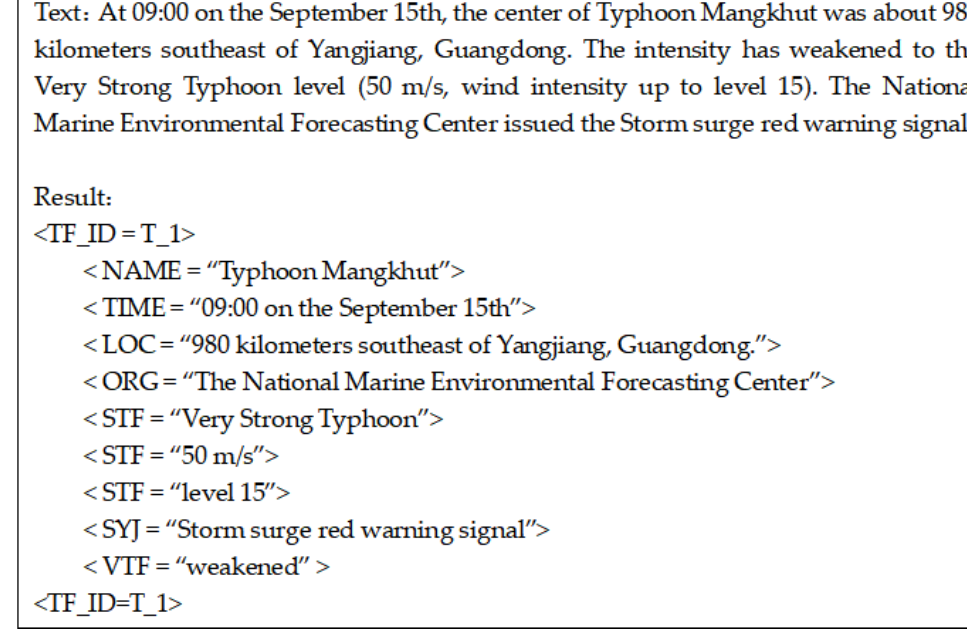
Figure 10. Part of the typhoon event graph in Neo4j database (In en-US). 3.3. Construction of the Disaster Chain for Typhoon Mangkhut Based on the scheme mentioned above, this research obtained 2984 news and Weibo texts related to Typhoon Mangkhut. After preprocessing the text, the typhoon event-ele- ments were obtained based on the model proposed in §2.2. According to the semantic similarity calculation method proposed in §2.3, the acquired typhoon information at the same time was fused. After several comparison experiments, the best fusion effect could be obtained when the threshold was 0.85, and the set of event-elements that were larger than the threshold was merged. At the end, based on the Typhoon Disaster Chain Ontol- ogy Model (TDCOM) constructed in §3.1, event-elements were expressed in structured form in chronological order. As shown in Figure 11, the disaster chain of Typhoon Mangkhut is constructed.